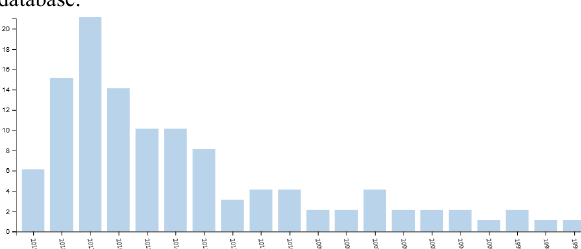
Figure 6. The results of query: TI= benchmark * AND all = ( photogrammetry or remote sensing ) in Web of Science